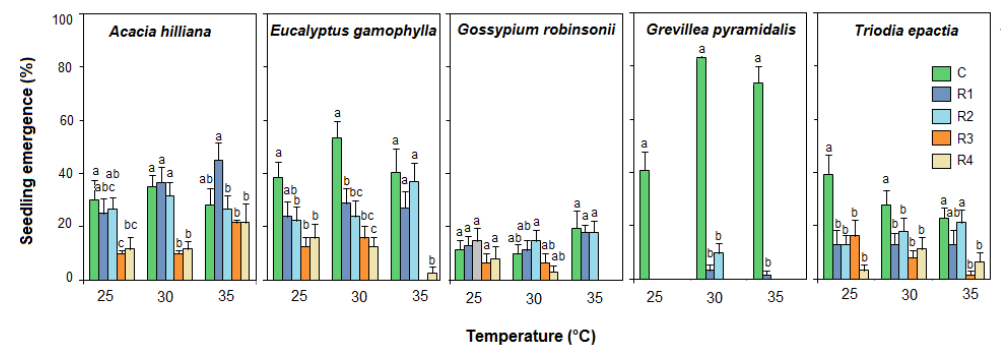
Figure 1. Total seedling emergence (%, mean ± SE, n = 12) of Pilbara native plant species under climate scenarios (temperature and rainfall). Different letters indicate significant differences over time among watering treatments (C, R1, R2, R3 and R4) for each temperature scenario (LSD post hoc test, P < 0.05). Watering treatments as described in Table 1.